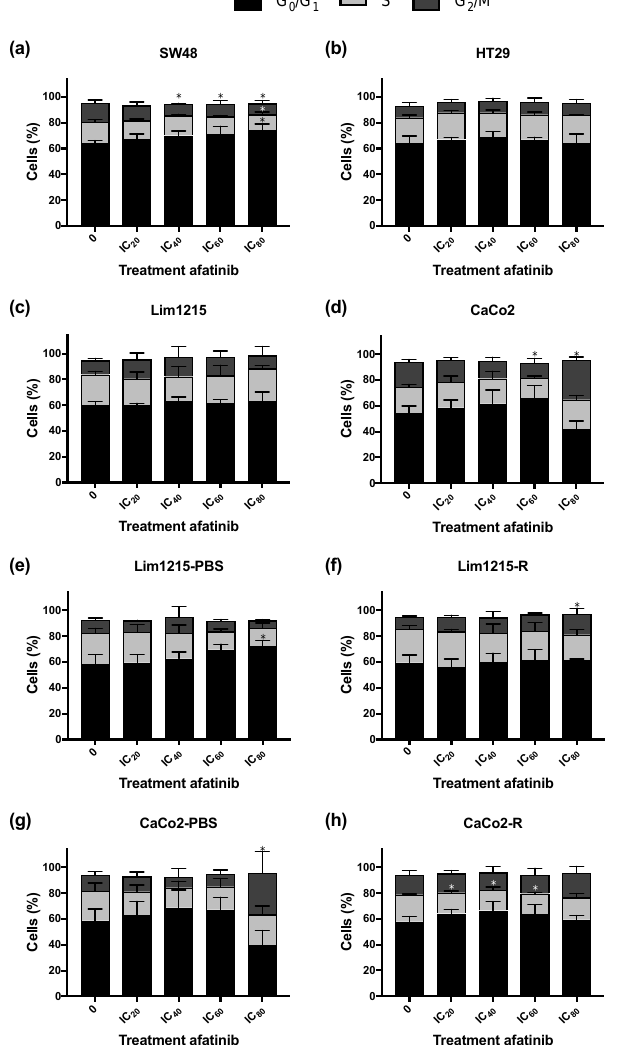
Figure 5. Cell cycle distribution in CRC cell lines after afatinib treatment (72 h, 0–IC 80 ). DNA content was measured using flow cytometry after staining the cells with propidium iodide (PI). Cells were divided into three groups: G 0 /G 1 phase (2n), S phase (2n–4n) and G 2 /M phase (4n). The effect of afatinib treatment on the cell cycle distribution of intrinsically cetuximab-resistant ( a,b ), cetuximab-sensitive ( c,d ), acquired cetuximab-resistant, and corresponding isogenic cetuximab-sensitive ( e–h ) CRC cell lines. * p -value treatment effect on the percentage of cells 0.050.